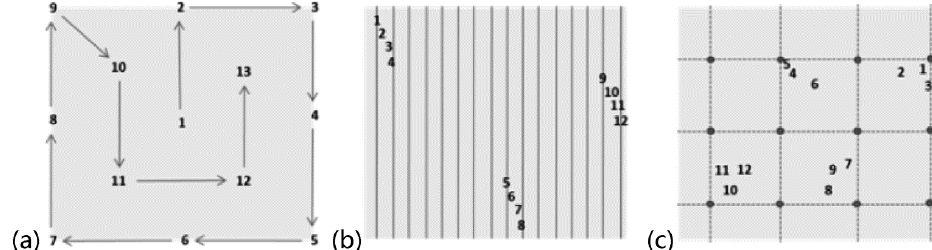
Figure A1. The examples of sampling schemes for ( a ) random, ( b ) row, and ( c ) regularly planted vegetation in an ESU. This figure was cited from Camacho et al. [56].